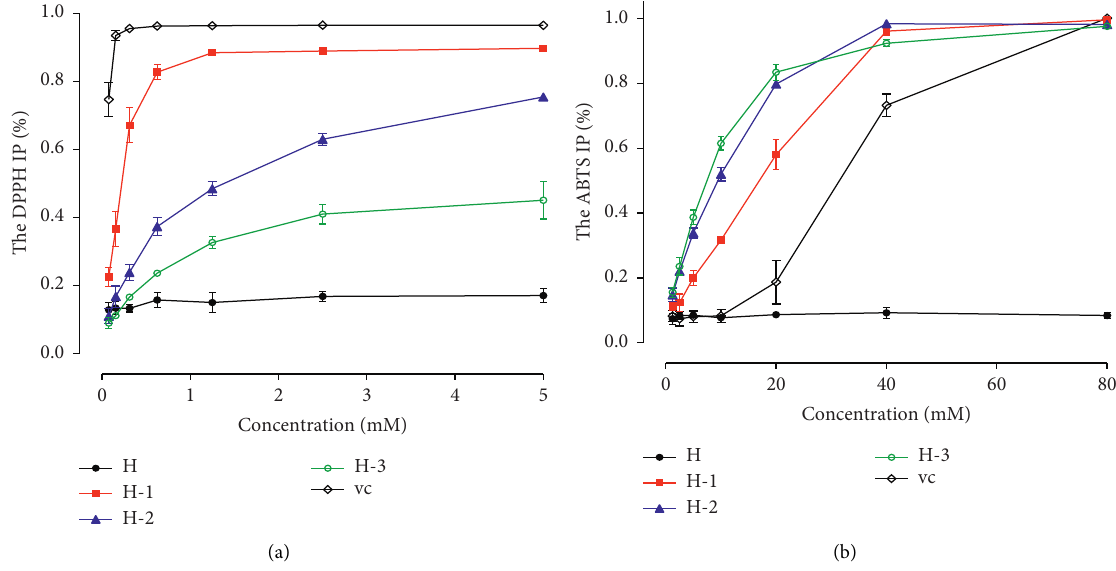
Figure 2: DPPH and ABTS free radical clearance curves of piperine and its derivatives. (a) The DPPH free radical clearance rate (IP) of piperine and its derivatives at different concentrations. (b) The ABTS free radical clearance rate (IP) of piperine and its derivatives at different concentrations. Table 1: IC 50 of the DPPH and ABTS free radical inhibition rates of the different piperine derivatives.